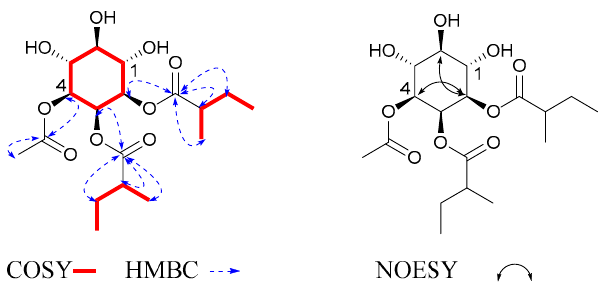
Figure 5. 1 H- 1 H COSY, key HMBC, and NOE correlations of compound 6. Compound 7 was obtained as a colorless solid. Its molecular formula, C 18 H 36 O 8 , was determined by positive HR-ESI-MS at m / z 408.2249 [M + NH 4 ] + (calcd. 408.2228) with four degrees of unsaturation. The 1 H and 13 C NMR spectra were close to compound 1 with the presence of one six-membered ring structure. The main difference was the side connections. In 1 H- 1 H COSY and HMBC (Figure 6) spectra, the correlation from H-1 to C-2MB indicated that the 2MB was attached to C-1; the correlation from H-2 to C-Ac indicated that the Ac was attached to C-2; the correlation from H-3 to C-2MB ′ indicated that the 2MB ′ was attached to C-3 [23]. The coupling patterns of six oxygenated methine protons were close to those of 1 . Therefore, compound 7 was myoinositol-1,3-(2-methylbutyrate)-2-acetate, and was named solsurinositol G.